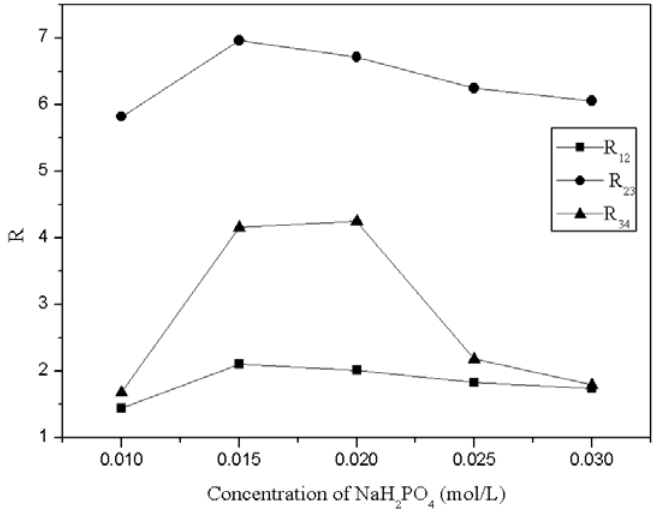
PO on the resolution of the four compounds. Figure 5 . Effect of concentration of NaH 2 4 (Error bars smaller than the symbols are not shown). 1: chlorogenic acid, 2: caffeic acid, 3: scoparone, 4: rutin; R = resolution of chlorogenic acid and caffeic acid; R 12 of caffeic acid and scoparone; R = resolution of scoparone and rutin. 34